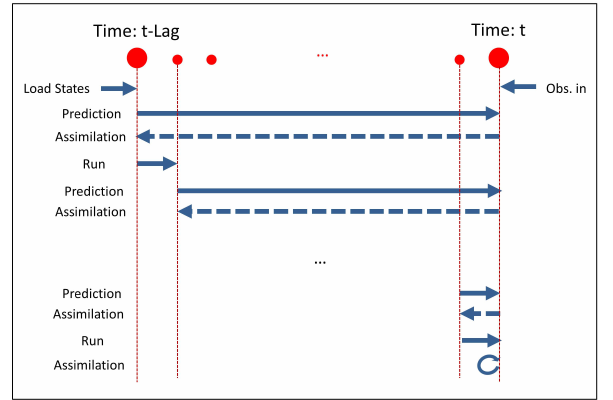
Fig. 1. Schematic showing REnKF algorithm to assimilate an ob- servation at time t